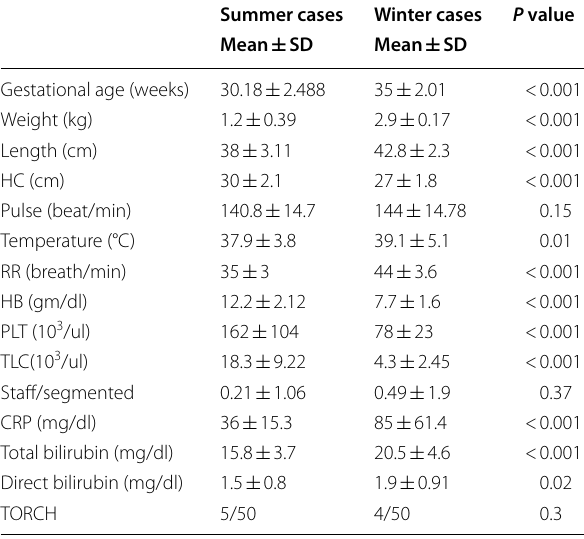
Table 1 The descriptive, demographic and laboratory data of cases